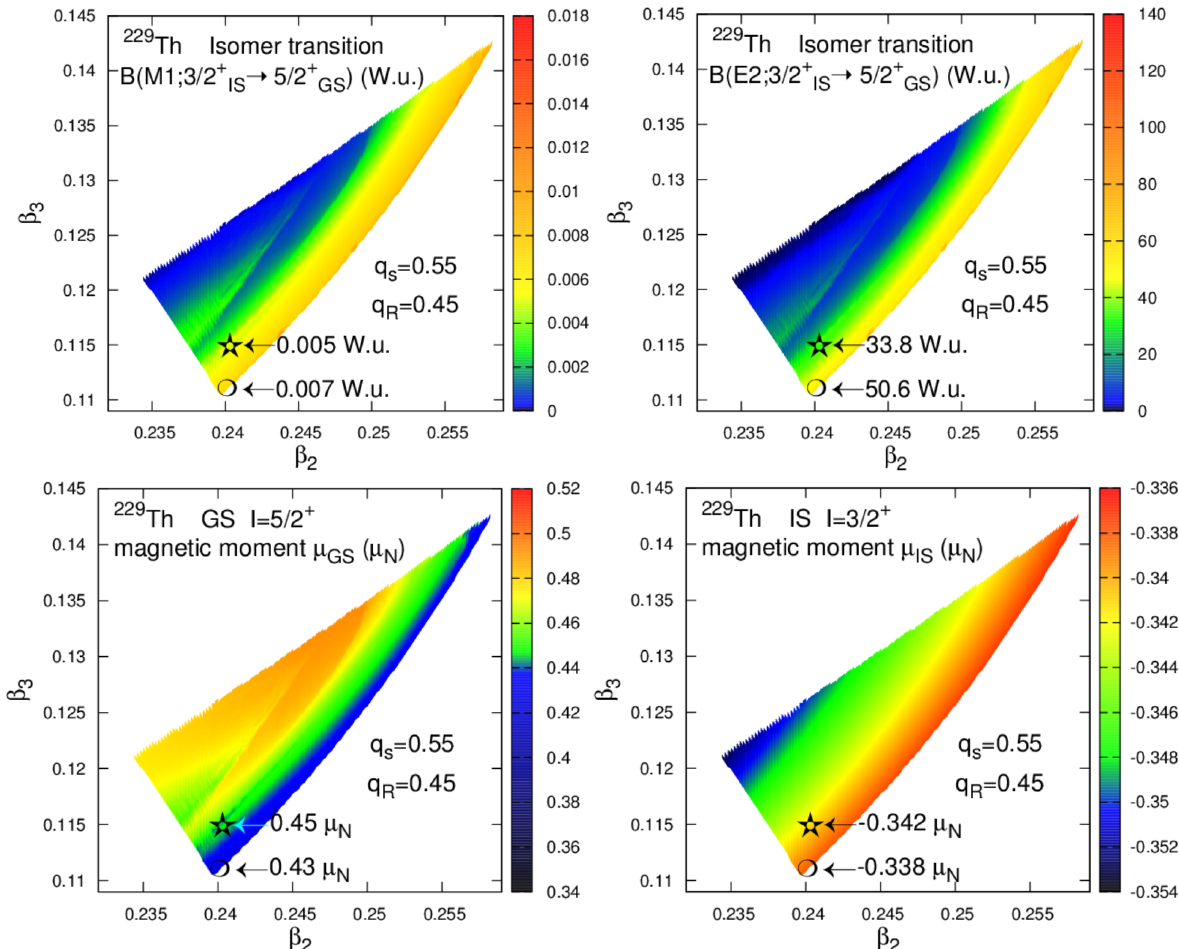
Figure 3. B( M 1), B( E 2) isomer transition rates and µ GS and µ IS values obtained by the model fits on a grid within the model-defined QO deformation space at q s = 0 . 55 and q R = 0 . 45. The open star indicates the location of the deformations ( β 2 ,β 3 ) = (0 . 240 , 0 . 115) adopted in Ref. [15]. The circle indicates the set ( β 2 ,β 3 ) = (0 . 240 , 0 . 111) situated closer to the degeneracy line. Adapted from